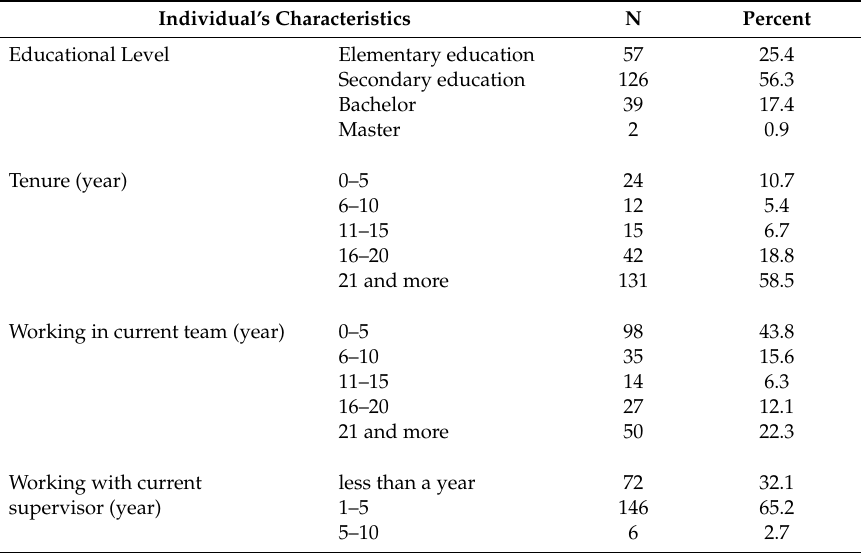
Table 1. Sample Characteristics (Individual level, N = 224, Team level, N =